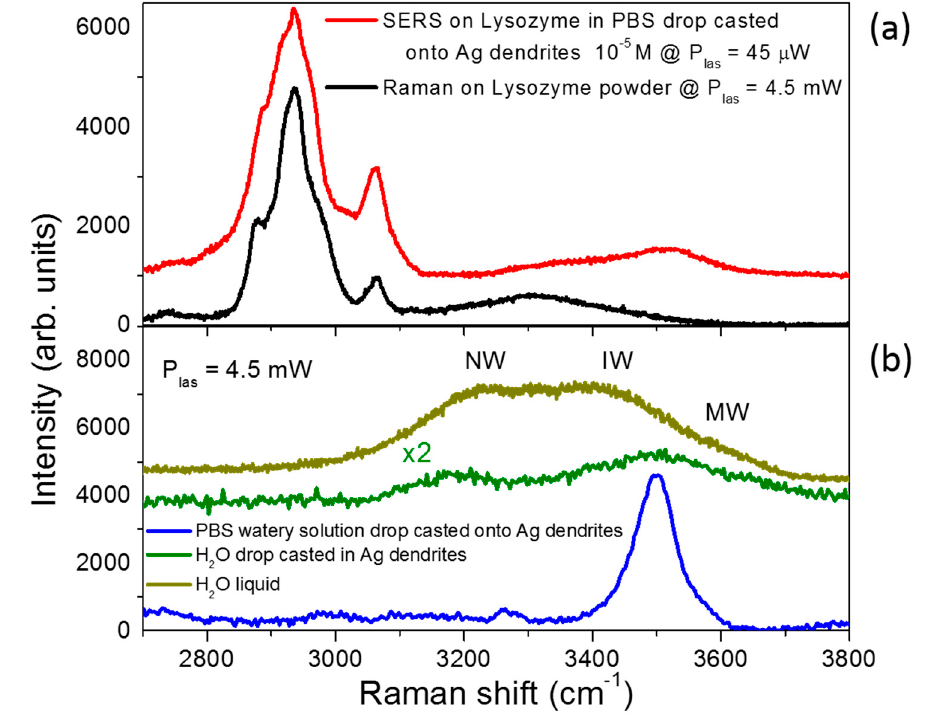
Figure 7. SERS signal from Lyz in the hydration region. Highlight of the SERS fingerprint of lysozyme onto Ag dendrites (in red) versus the lysozyme powder Raman spectrum (in black) in the water hydration region. For a better comparison, the spectra of the PBS solution drop casted onto the Ag dendrites (in blue), the water drop casted onto the Ag dendrites (in green), and liquid water are also presented (dark yellow). For all the spectra, we used the same 100 × microscope objective with an integration time of 30 s, while we adopted a laser power of 4.5 mW for the Raman spectra and a laser power of 45 µ W for the SERS one (red line in ( a )). For the spectrum measured of the liquid sample (dark yellow line in ( b )), we used glass microcells as sample holders.